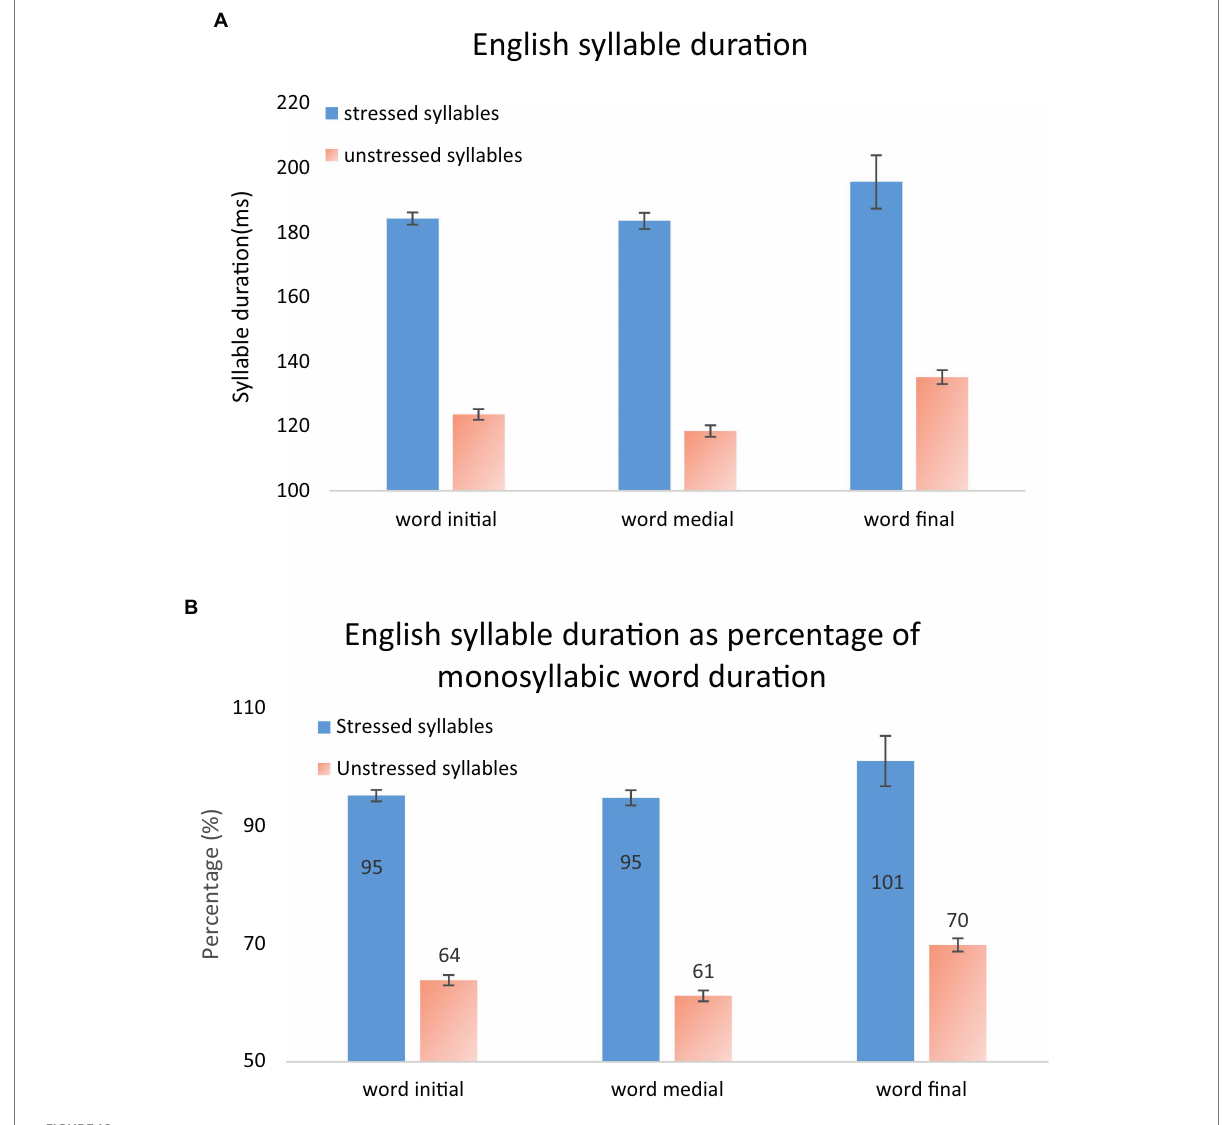
FIGURE 12 English syllable duration as a function of position in word, in (A) milliseconds, and (B) percentage of monosyllabic word